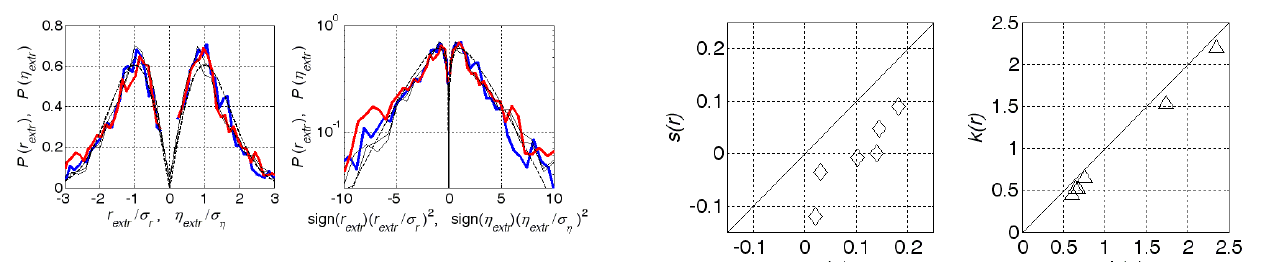
Fig. 9. Mean sea level for different values of s Br . Circles correspond to runup, crosses to the incident wave, and dashed lines to the theoretical Eq. (11).